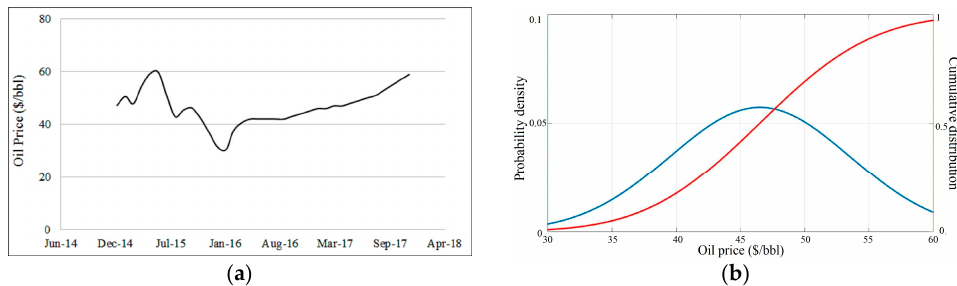
Figure 8. ( a ) The historical and forecasted oil price (www.eia.gov); ( b ) Normal distribution of the oil price: probability density and cumulative distribution curves, with the maximum, minimum and mean values are 60, 30 and 46.5 $/bbl, respectively. Table 4. Detail comparison of different flooding sequences in terms of recovery factor, total injected volume and chemical expenses.